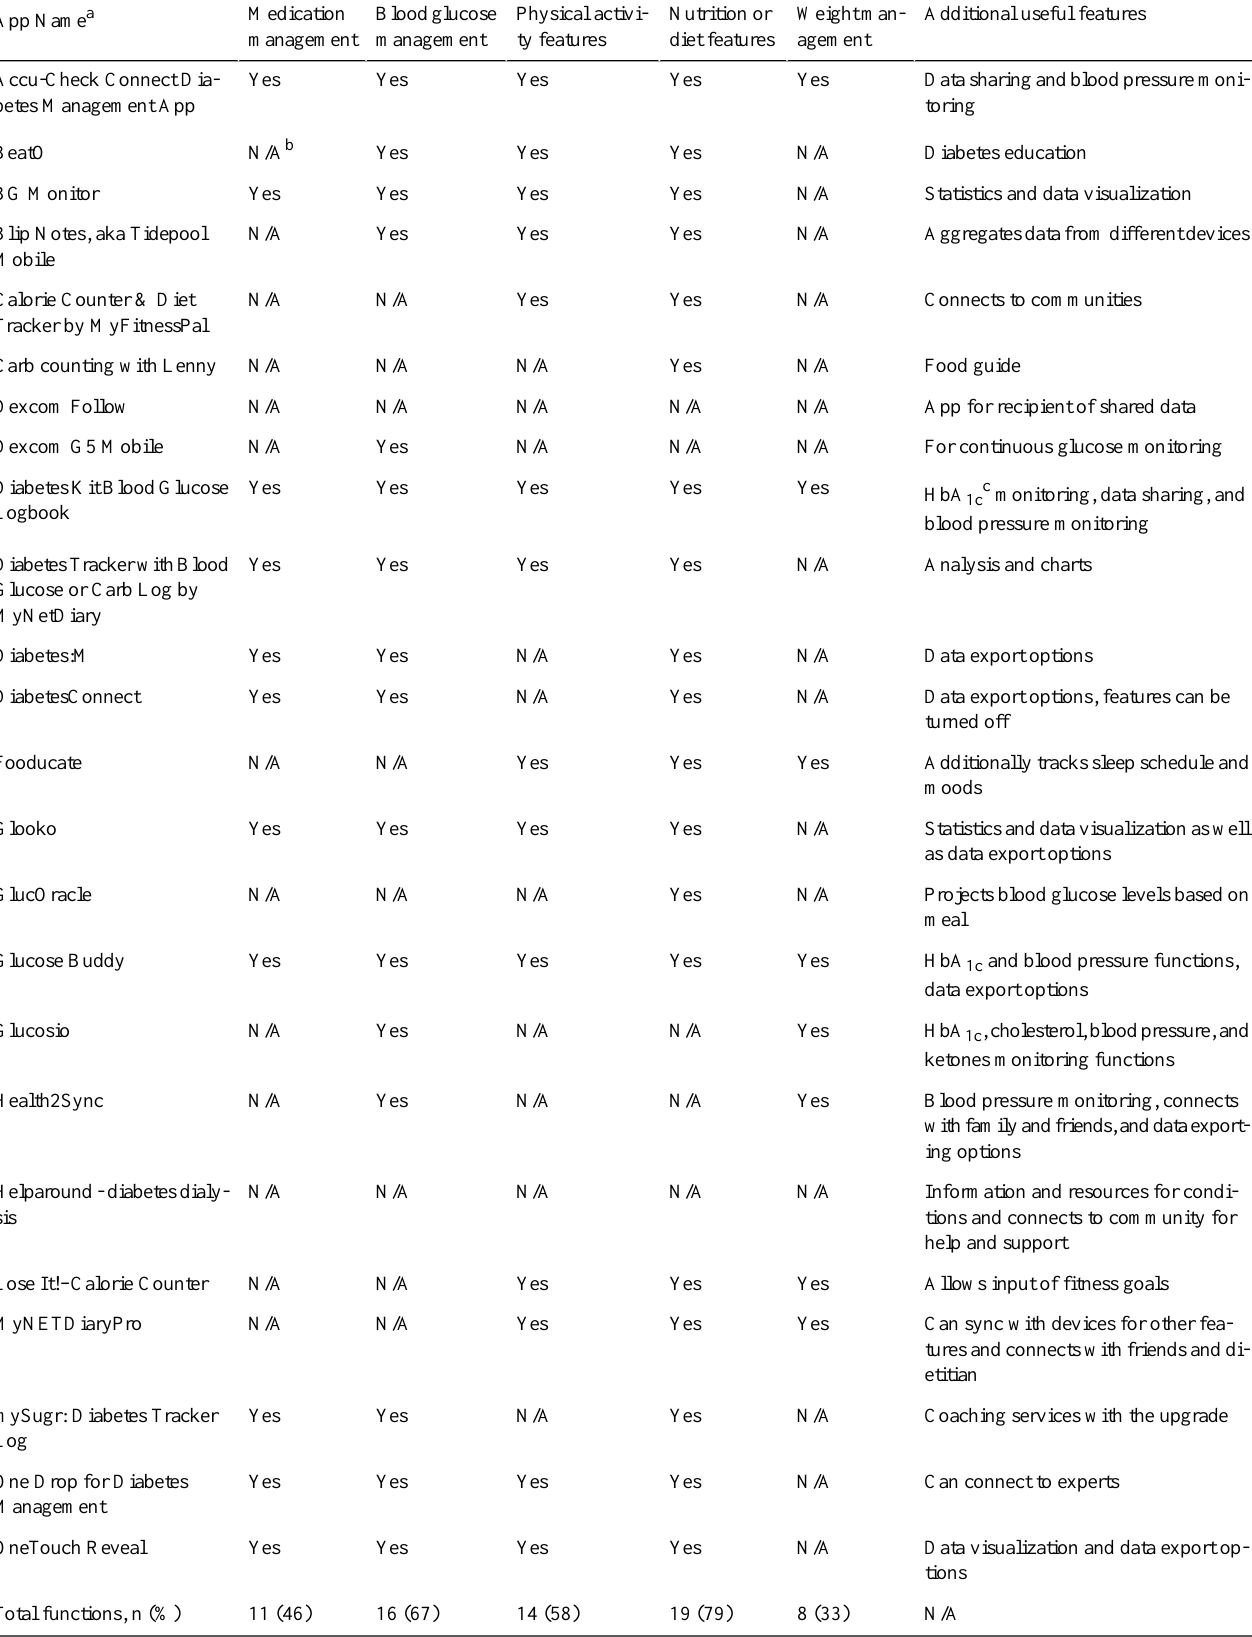
Table 1. Diabetes management-related functions included in each app